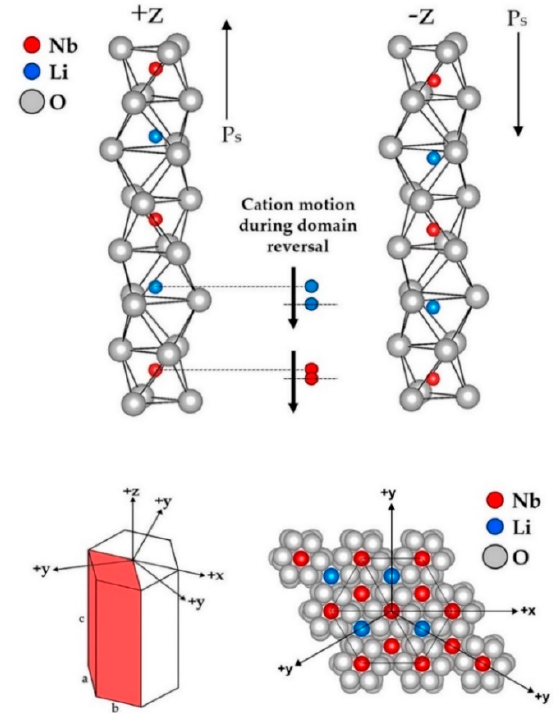
Figure 3. Crystal structure of ferroelectric LiNbO 3 under two cation displacement possibilities with respect to each equidistant oxygen octahedra. Upper left: Z+ orientation of cation displacement. Upper right: Z- orientation of cation displacement. Bottom left: conventional choice of axes for the ‘orthohexagonal’ setting ( XYZ ) with respect to the hexagonal setting ( a , c ). Notice that whereas in the hexagonal setting, all axes have an equal length, they all are different in the cartesian one. Bottom right: projection of the atomic arrangement along the c -axis.